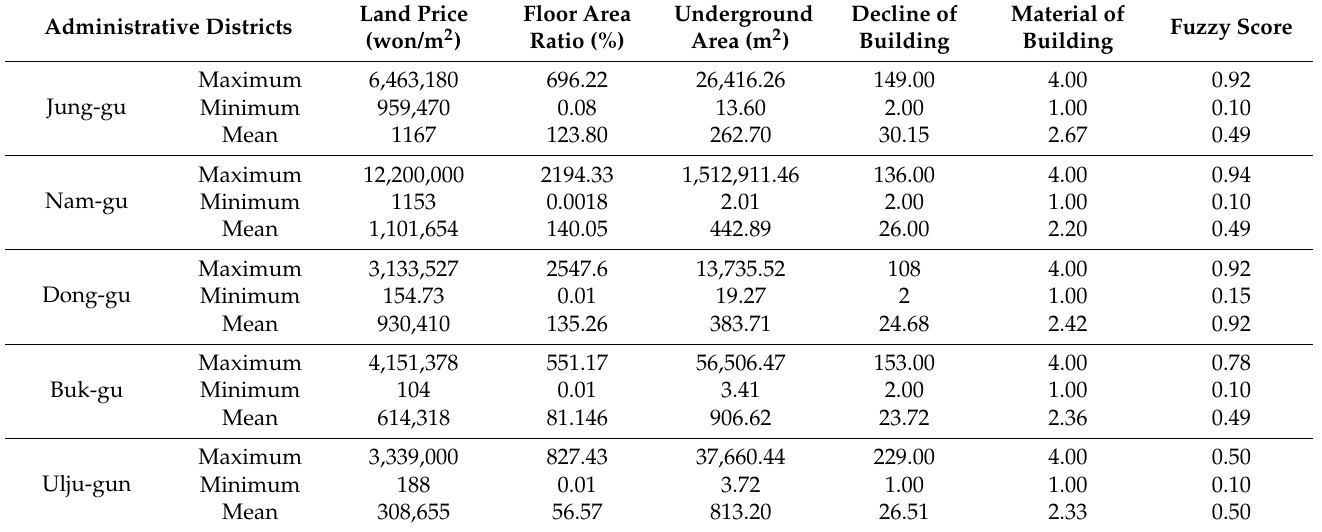
Table 4. Fuzzy for building unit.